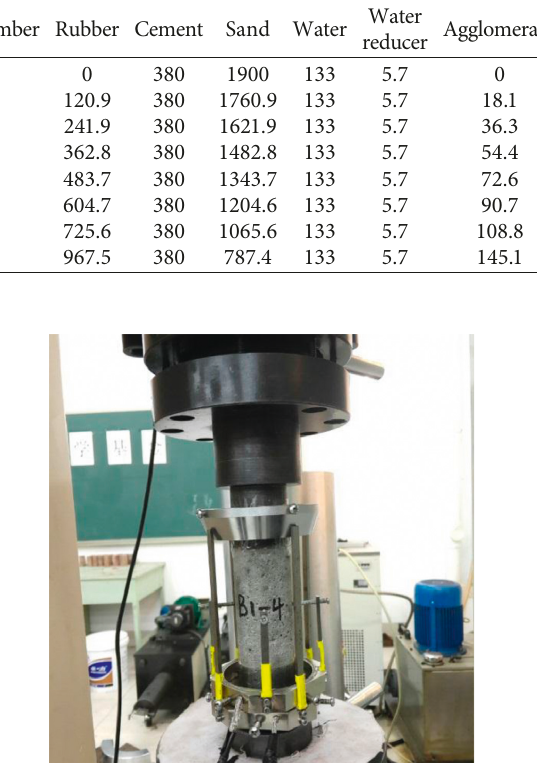
Figure 2: Specimen under uniaxial compression